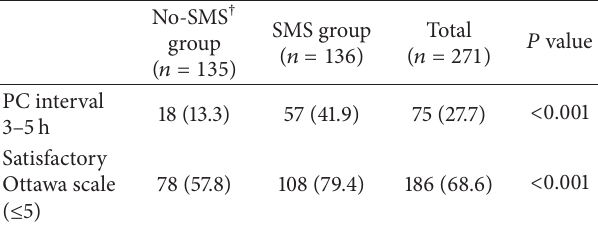
Table 3: The relationship of intervention using SMS and PC interval ∗ .